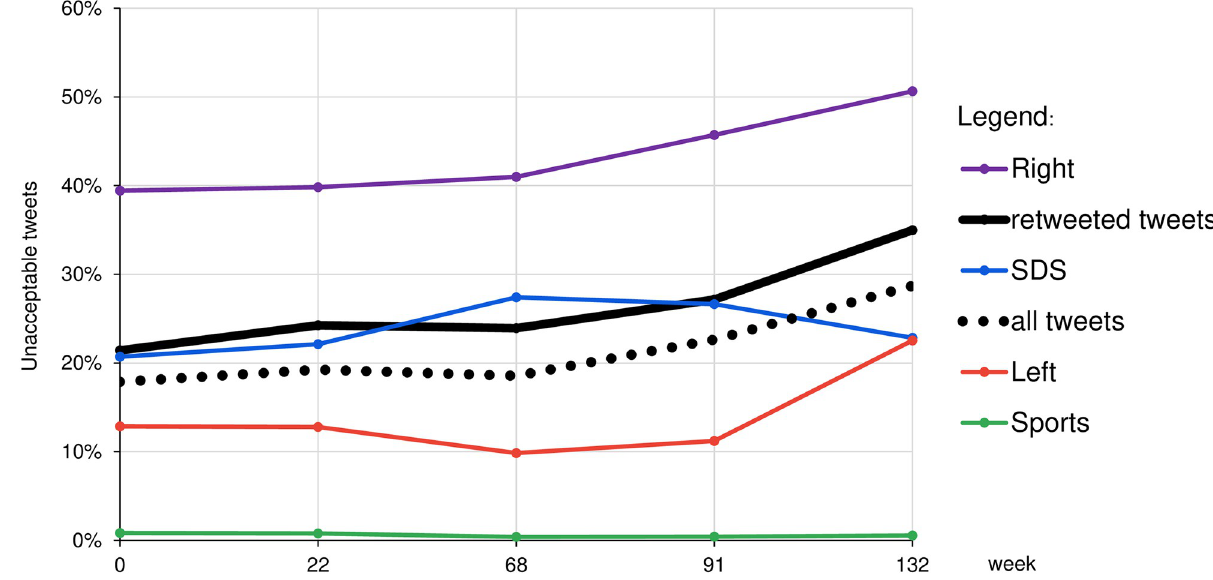
Fig 3. Fractions of unacceptable tweets posted by the major communities and overall, at weekly timepoints t = 0, 22, ... , 132. The solid black line represents all the tweets that were retweeted and are used to form retweet networks and communities. The dotted black line represents all the tweets posted. The largest communities are Left, Right, and SDS. For a comparison, we also show Sports, a small community with almost no unacceptable tweets.